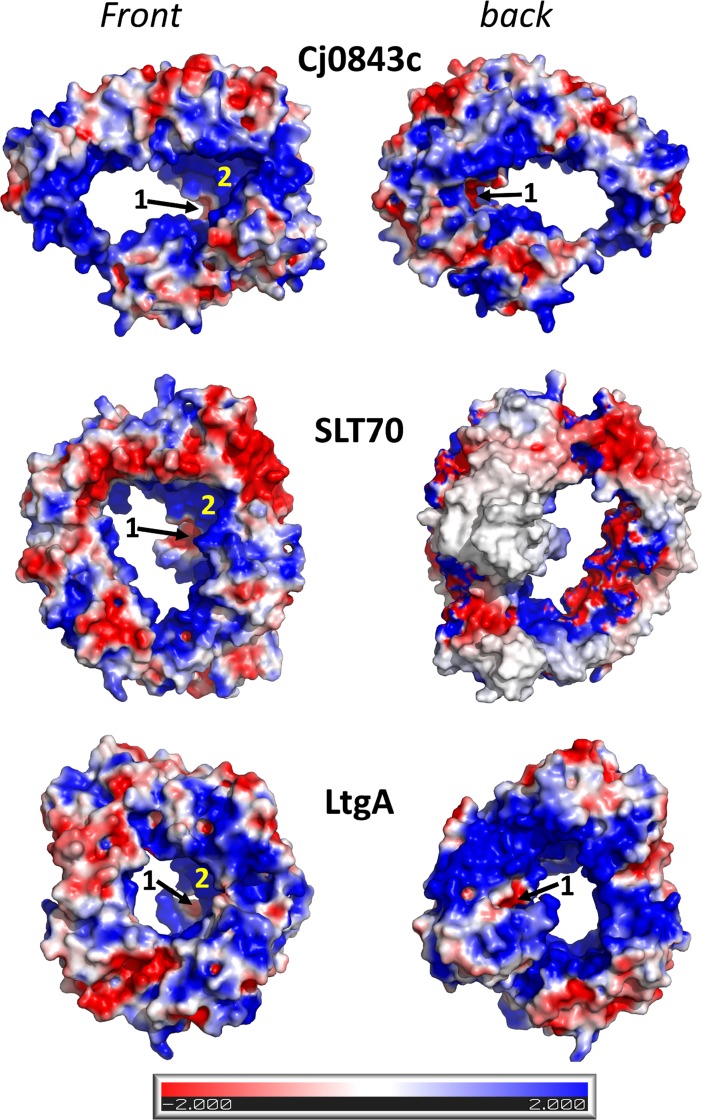
The electrostatic surface potential of Cj0843, SLT70, and LtgA.The electrostatic surface calculations were done using APBS [41], and two opposite views of the doughnut-shaped proteins are shown. The active site groove is indicated by an arrow and labeled ‘1’; the positively charged pocket 2 is indicated by a yellow ‘2’.